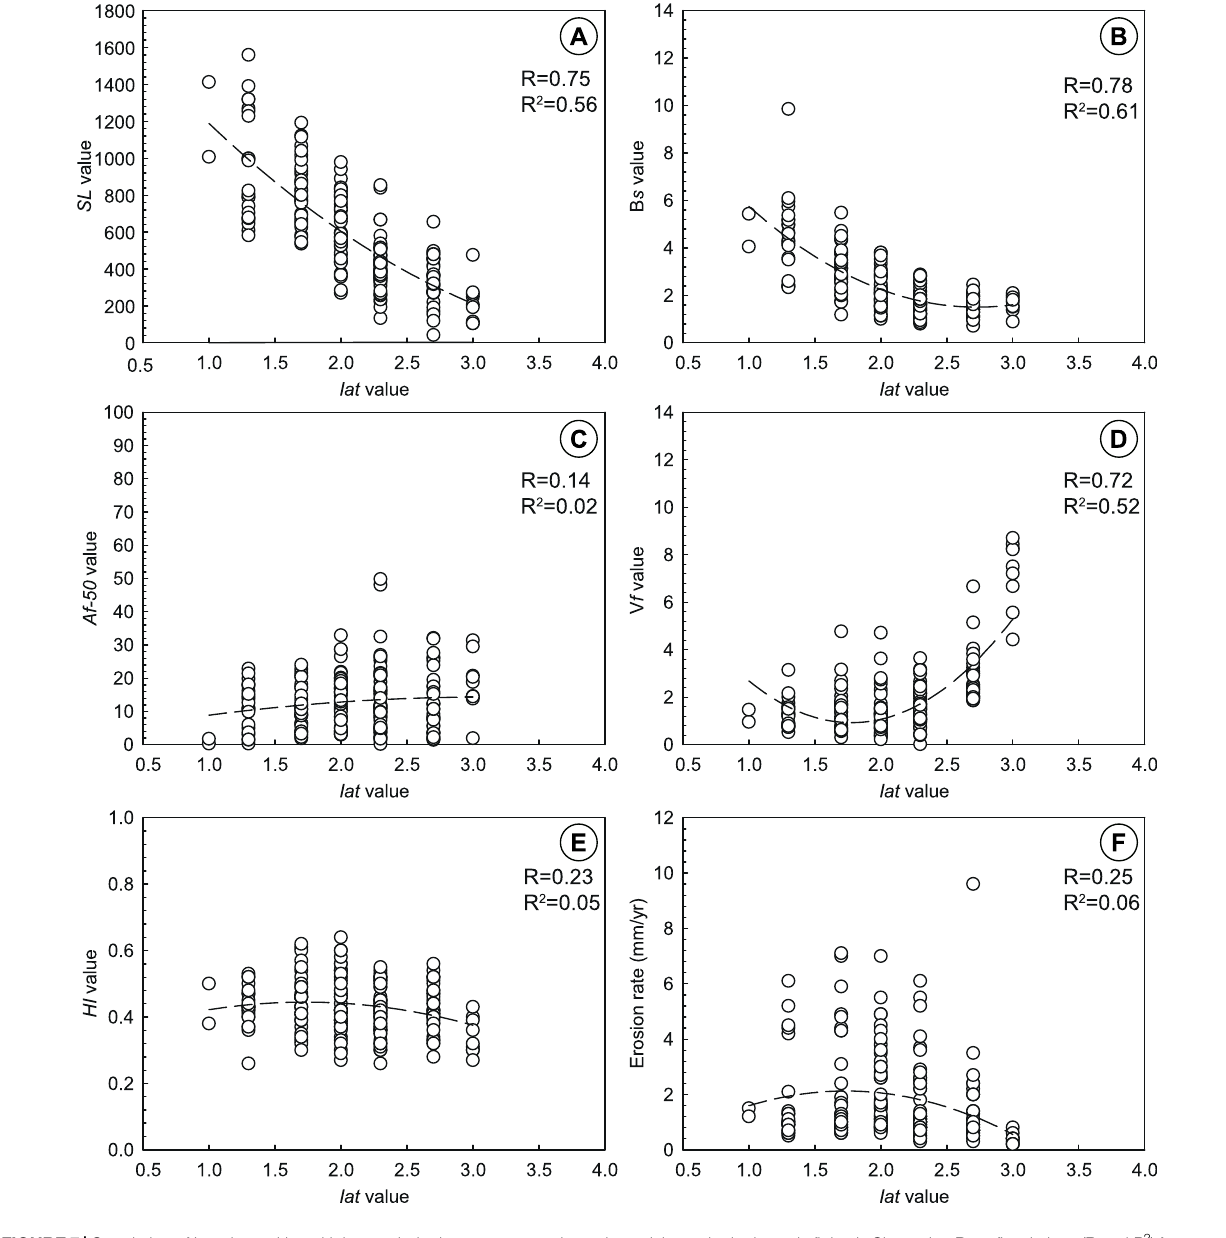
Frontiers in Earth Science |